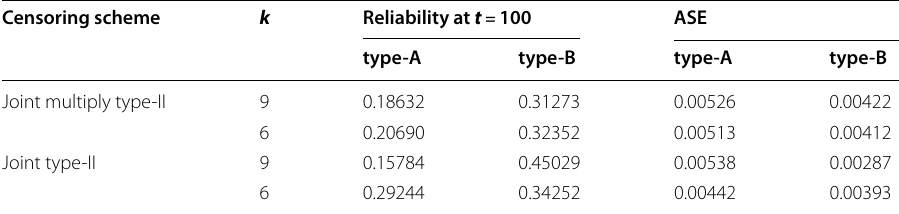
Table 5 Reliability and ASE Censoring